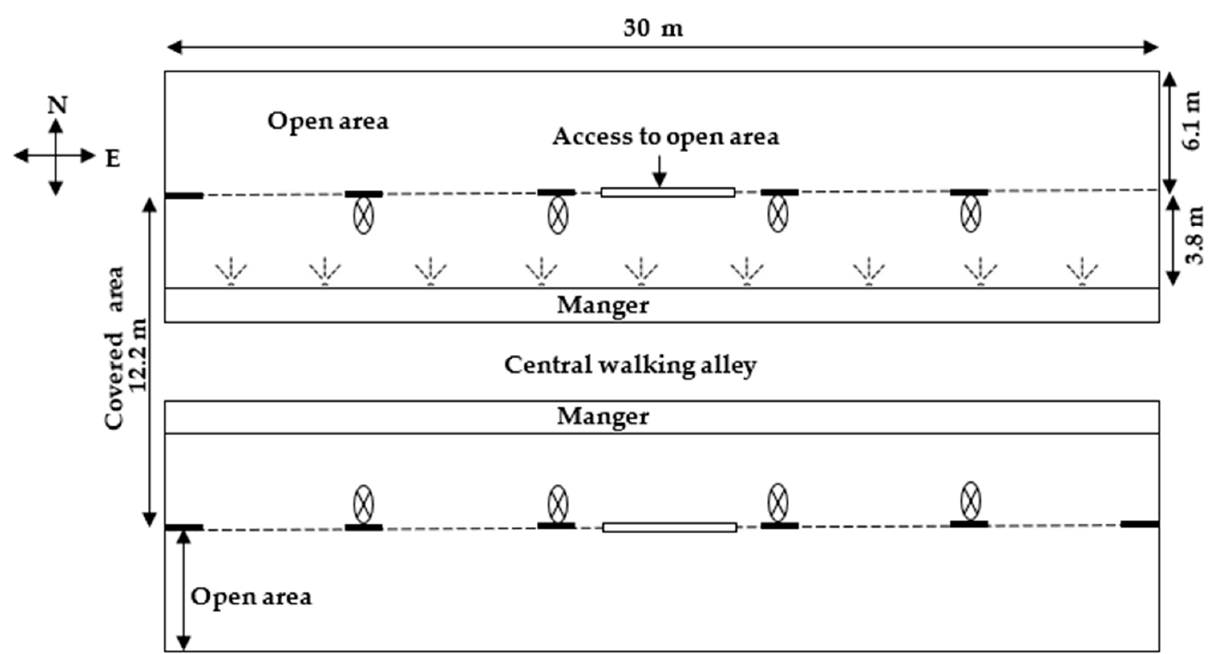
Figure 1. Schematic diagram of the experimental shed to investigate the effect of different sprinkler flow rates and cooling schedules on cooling efficiency in Nili Ravi buffaloes during summer. The dashed lines (---), cross in a circle ( ), and combined doted three lines ( ) indicate windows, fans, and sprinklers, respectively, and each sprinkler was for one buf- falo.